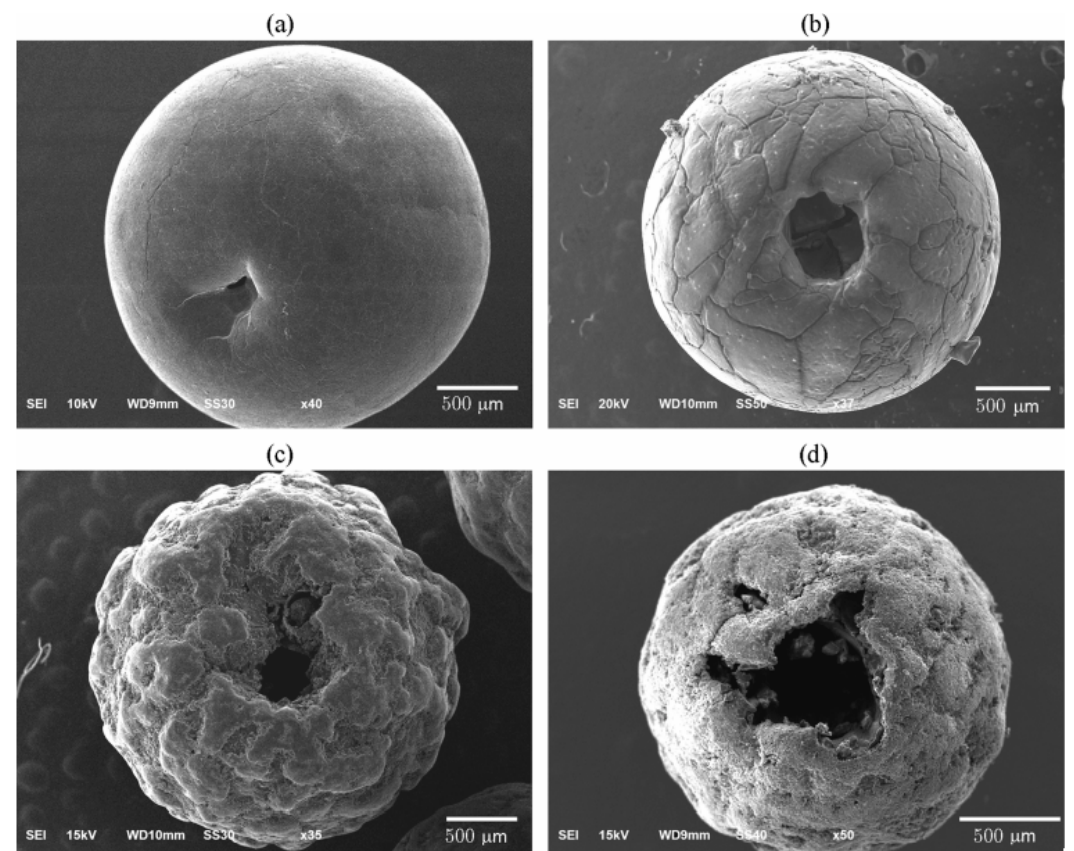
Figure 3. View of the outer surface of ammonium nitrate granules on the side of the shrinkage cavity: ( a ) GOST No. 2-2013 AN; ( b ) the same AN after thermal treatment (PorAN); ( c ) porous AN from China (PAN-MH); ( d ) porous AN from France (PAN-GP). Reprinted with the permission of Springer Nature from [26], copyright 2016.